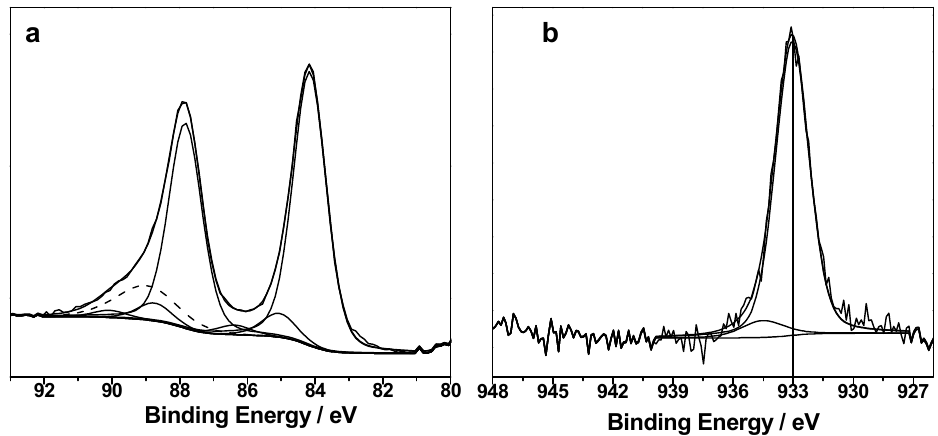
Figure 8. ( a ) Au4f XP region relevant to used AuNPs@SiNWs (the dashed line corresponds to Mg2s signal, due to contamination); ( b ) Cu2p 3/2 XP region relevant to used CuNPs@SiNWs (the vertical line indicates the position of the main component).